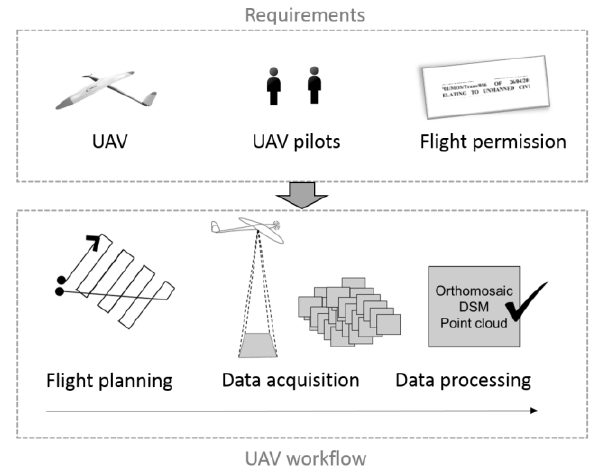
Figure 2. Key ingredients for a UAV-based land tenure recording